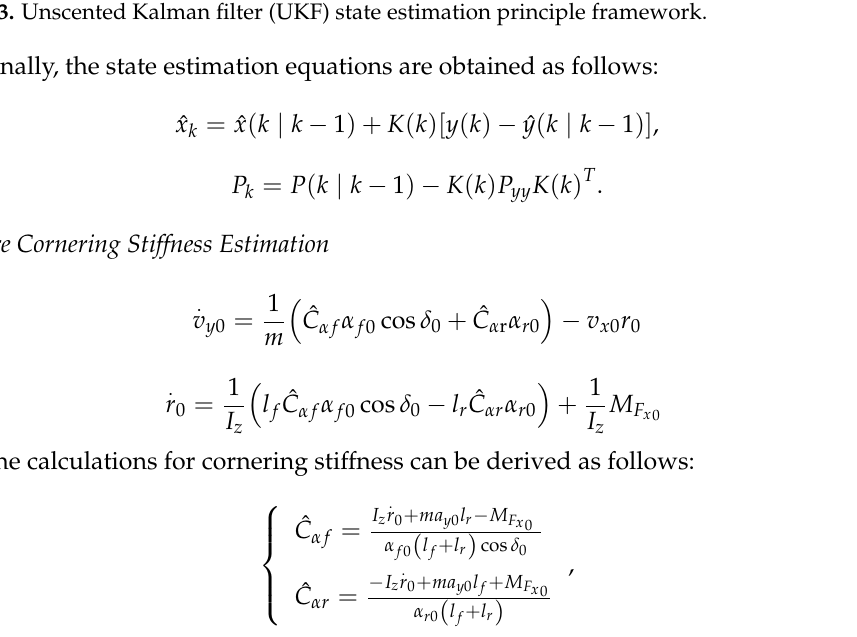
Figure 3. Unscented Kalman filter (UKF) state estimation principle framework.